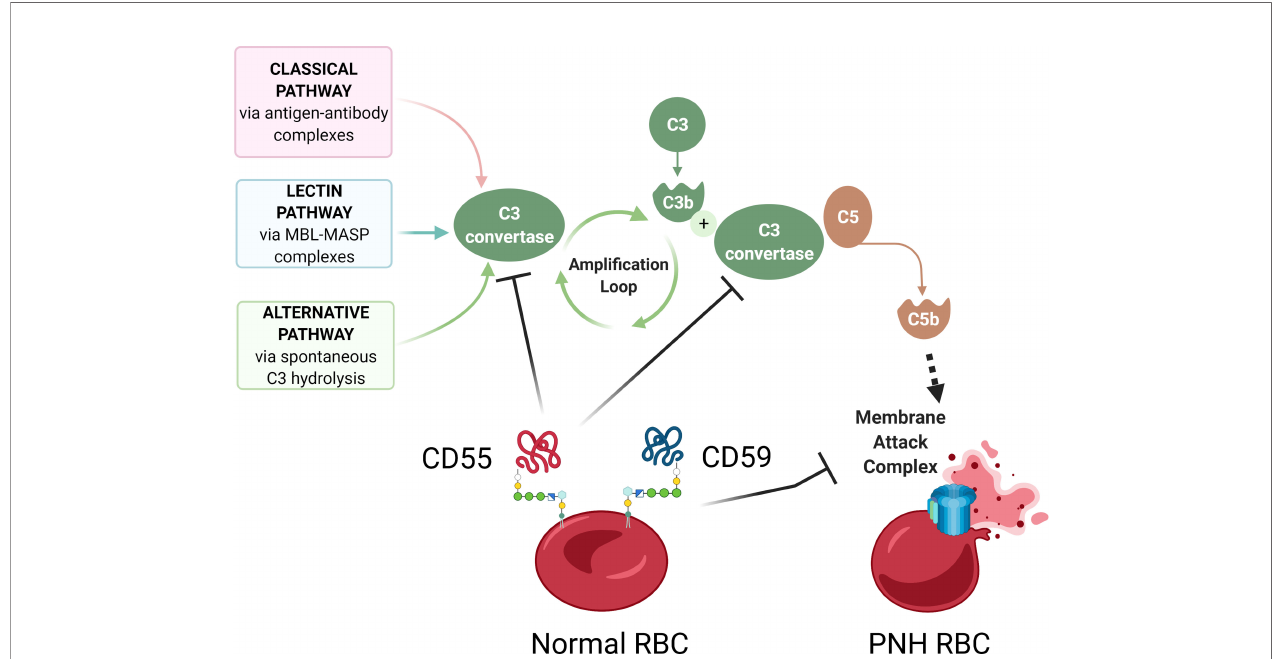
FIGURE 2 | Complement-mediated hemolysis in PNH. A schematic diagram showing aberrant complement activation on PNH erythrocytes due to the de fi ciency of GPI-anchored proteins CD55 and CD59. The Classical, Lectin, and Alternative pathways of complement activation lead to the formation of C3 convertase, which cleaves C3 into C3a and C3b, leading to formation of C5 convertase, which cleaves C5 to C5b, to activate terminal complement components and form the membrane attack complex (MAC). In normal red blood cells (RBCs), GPI-anchored surface proteins CD55 and CD59 inhibit complement activation by blocking C3 convertase and membrane attack complex, respectively. In the absence of CD55 and CD59, GPI-de fi cient PNH RBCs have uncontrolled complement activation and lysis. Diagram made with BioRender.com; complement pathways adapted from “ Roles of the Complement Cascade in Innate Immunity ” by BioRender.com